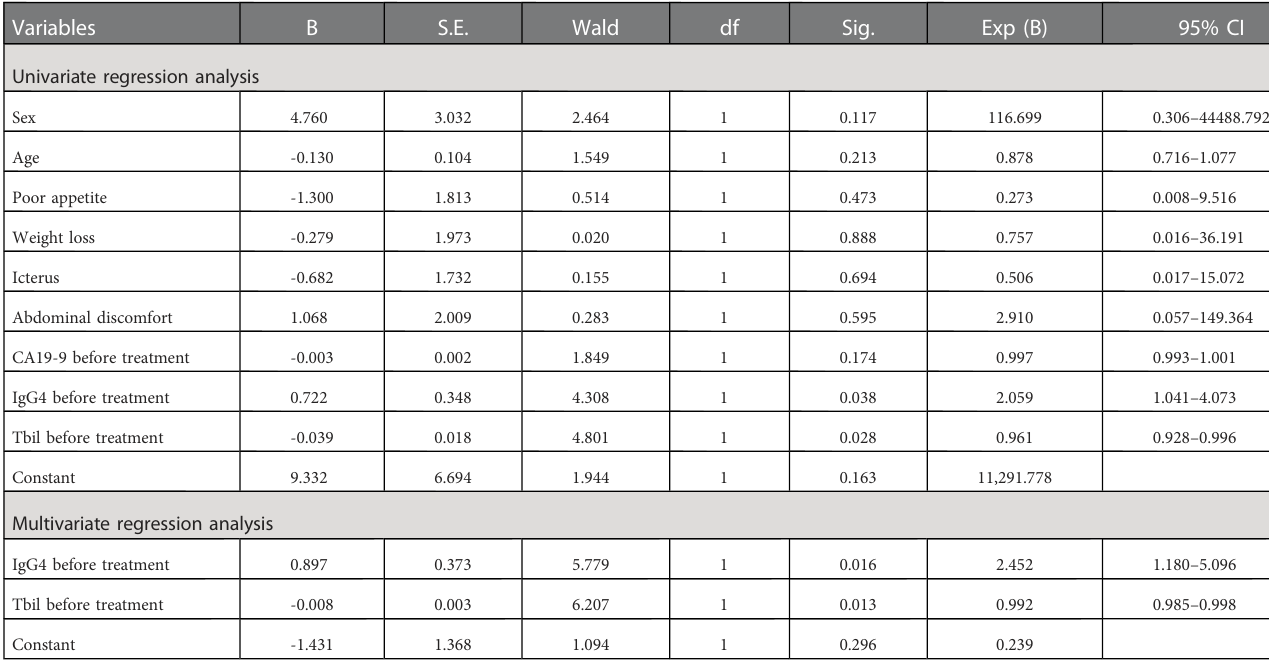
TABLE 2 Univariate and multivariate regression analyses of the risk factors of AIP.